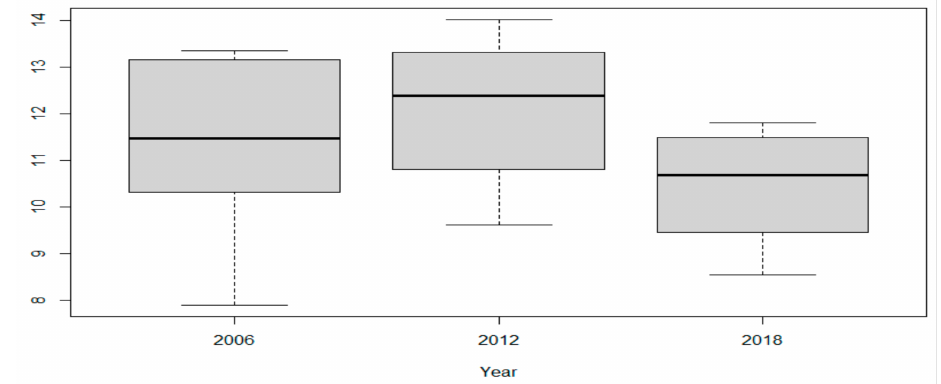
Figure 8. Development of waste cost in time (in € /kg).